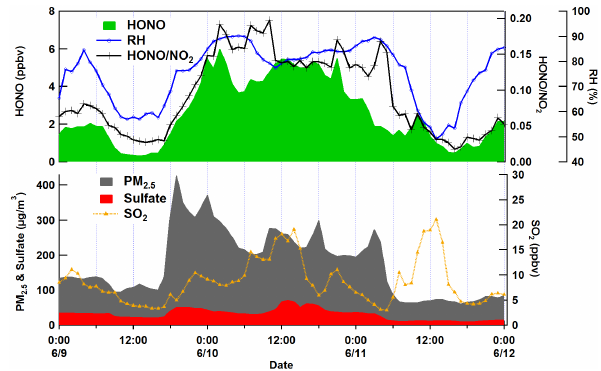
Figure 12. Temporal variations of HONO, HONO / NO 2 ratios, RH, PM 2 . 5 , sulfate in PM 2 . 5 and SO 2 during 9–11 June 2012 at the SORPES station.